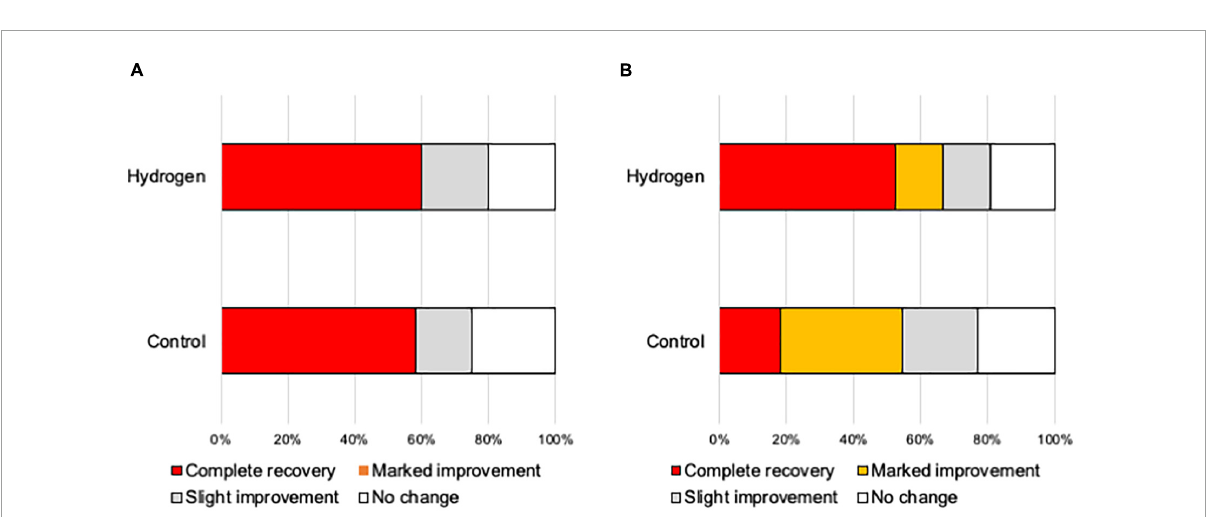
FIGURE5 Hearing outcomes depending on the severity of hearing loss at the initial visit. (A) Hearing outcomes among patients with mild hearing loss. The ratio of good hearing prognosis (complete recovery and marked improvement) did not vary between the groups. (B) Hearing outcomes among patients with severe hearing loss. The ratio of good hearing prognosis did not vary between the groups. However, the ratio of complete recovery was significantly greater in the H 2 group than in the control group ( P = 0.02).